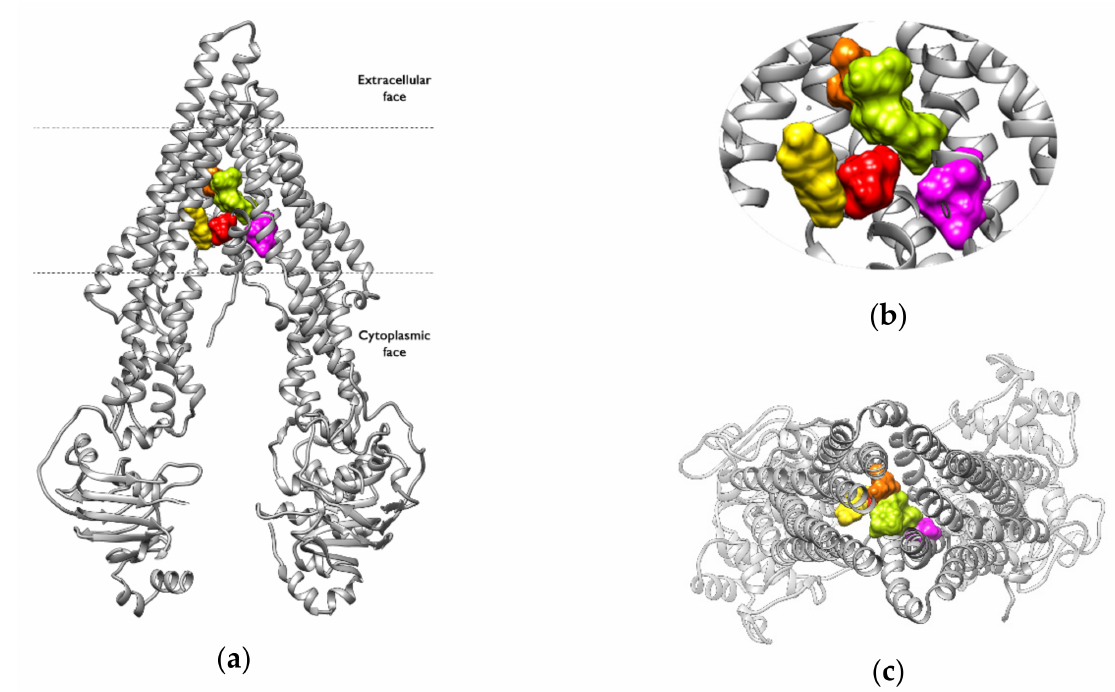
Figure 7. Interaction region of the non-active compounds within the binding pocket: ( a ) frontal view, ( b ) zoomed view, ( c ) view from the extracellular side of the protein looking into the inner chamber. The ligands are shown in the surface representation: APD is shown in red, BUS in is shown magenta, GEN is shown in light green, PQT is shown in yellow, and VPA is shown in orange.